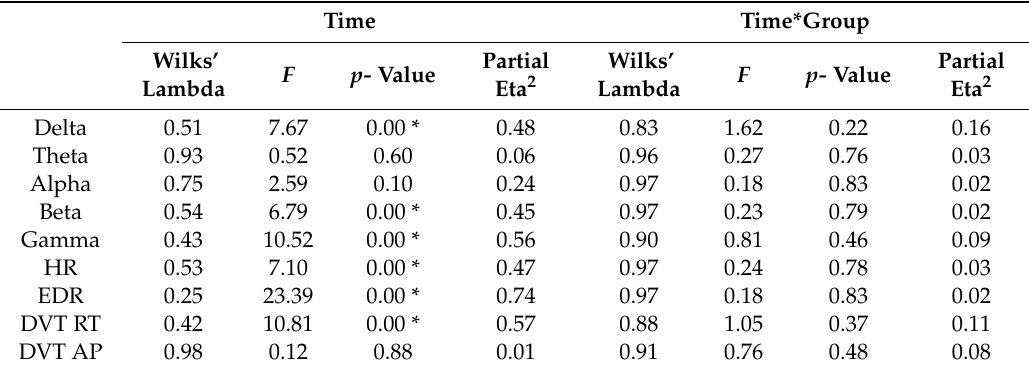
Table 2. Between and within group interaction of the study variables.